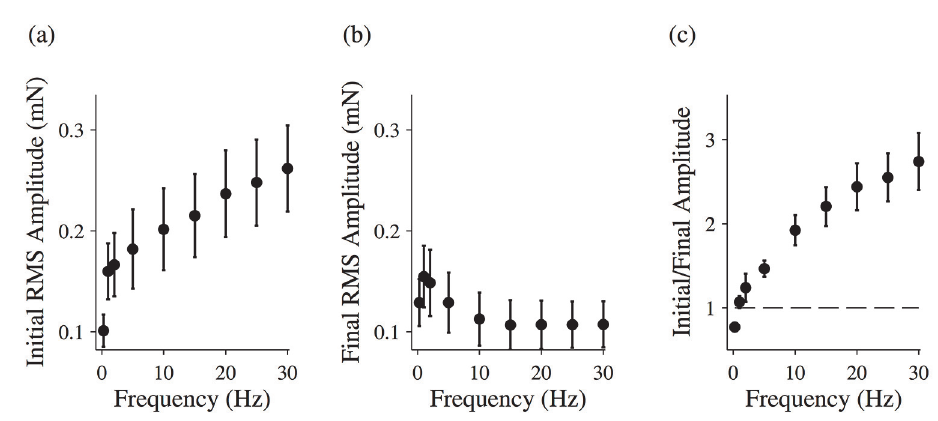
Fig 5. Changing force response for activated muscle fibers. The root-mean-squared (RMS) amplitude for the initial driving oscillation (a) and the final driving oscillation (b) for activated muscle fibers. (c) The ratio of the initial and final RMS amplitudes for activated muscle fibers. The total length of the oscillation was 20 seconds. All data points are (MEAN ± SEM), and the number of fibers analyzed was N =